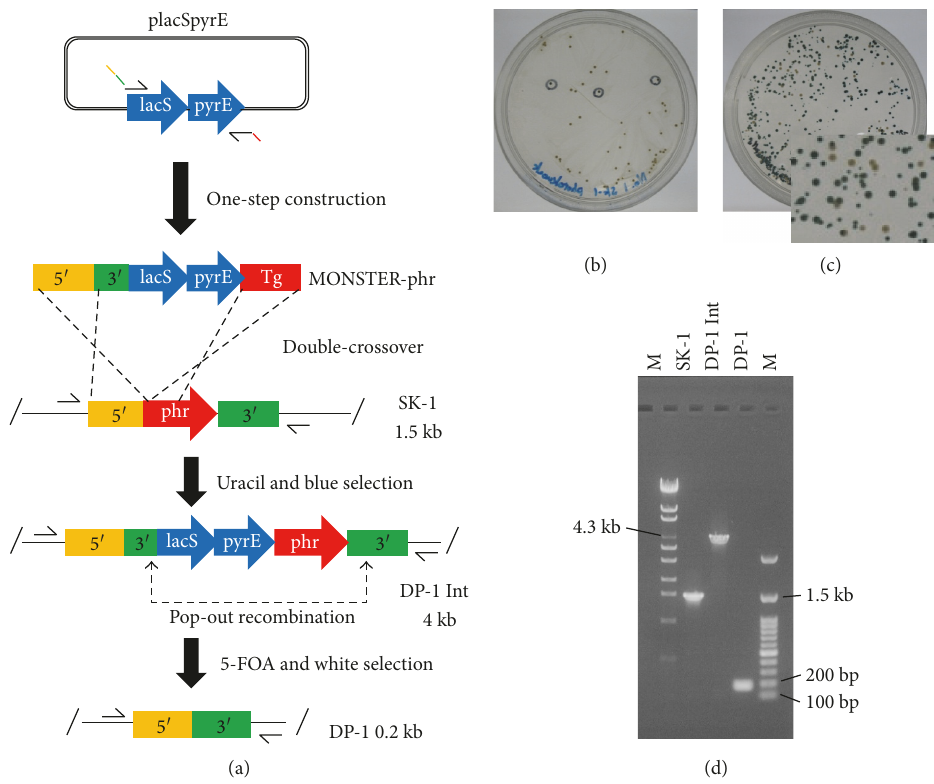
Figure 4: Schematic of the multiple gene knockout system with one-step PCR (MONSTER). (a) Construction of a DNA photolyase-encoding gene ( phr ) deletion mutant. A plasmid-borne pyrE - lacS marker served as the PCR template, which attached S. acidocaldarius chromosomal sequences (5 ′ , 3 ′ , and partial sequences of phr at the 5 ′ ends of the primers) to the ends of the selectable dual marker. After one-step construction, the MONSTER-phr was electroporated into strain SK-1. A double crossover between the MONSTER-phr and the chromosome at the 5 ′ and Tg regions results in the pyrE - lacS marker and 3 ′ region insertion at the phr locus. The resulting uracil prototroph transformants that exhibit blue colonies can be selected on uracil-free plates. A DNA photolyase deletion mutant with the marker removed was generated by pop-out recombination at two duplicated 3 ′ regions, which can be selected by 5-FOA counterselection in combination with X-gal staining. Arrows show the positions of PCR primer sets. (b) Uracil and blue selection plate. (c) 5-FOA and white selection plate. (d) PCR analysis of the phr locus of the S. acidocaldarius strains SK-1 ( Δ pyrE Δ suaI ), DP-1 Int (intermediate), and DP-1 ( Δ pyrE Δ suaI Δ phr ) using phr-out-F/R as primers. The expected sizes of the PCR bands were 1.5kb (wt), 4kb (recombinant), and 0.2kb (deletion mutant). A λ -EcoT14 or 100bp DNA ladder was loaded in lane